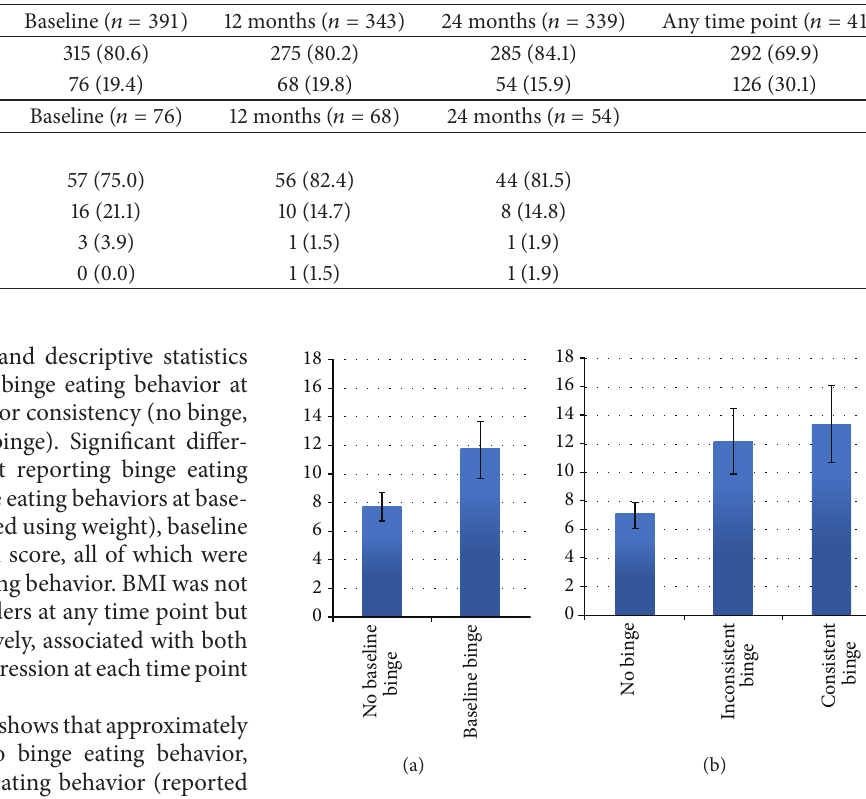
Figure 1: Two-year weight change (lbs) by (a) baseline binge eating statusand(b)bingeeatingcategory.Errorbarsrepresent ± 1standard